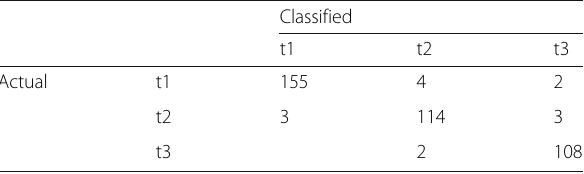
Table 7 Confusion matrix for the thermal image classifier (3 types) (t1: sedan, t2: SUV, t3:truck)